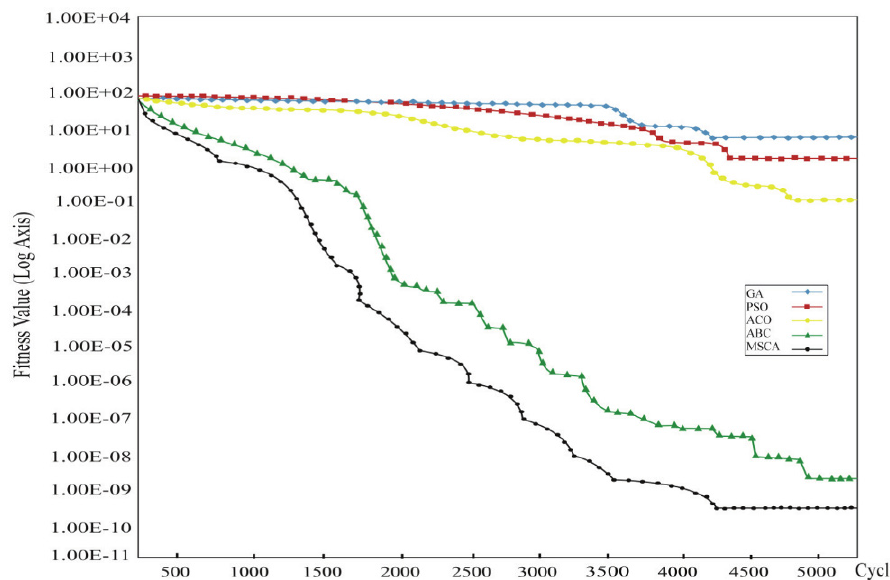
Figure 7. The results of applying different algorithms on Non-continuous Rastrigin